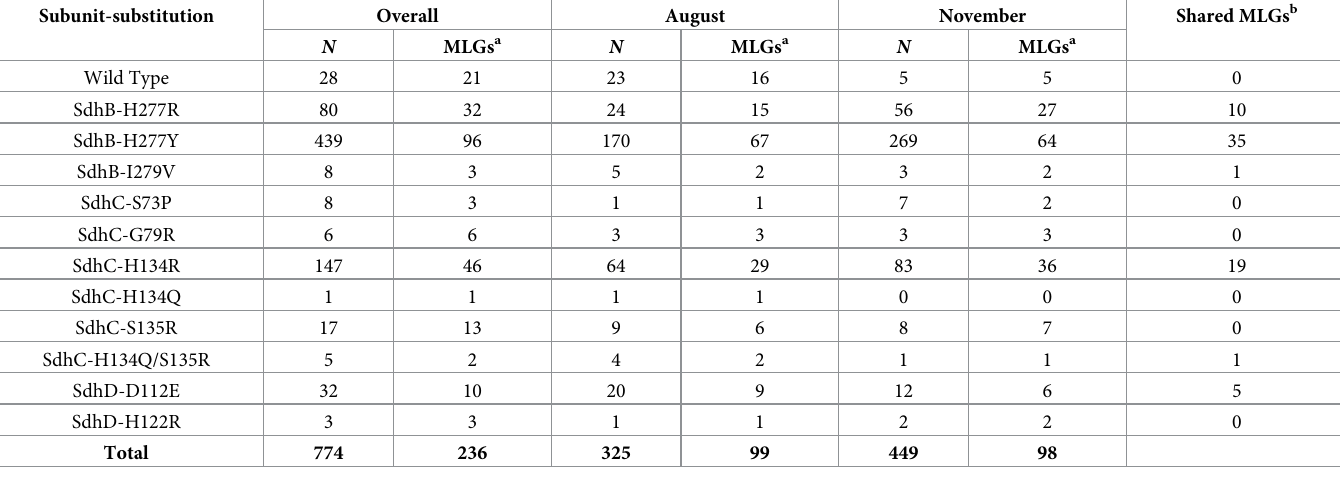
a Multi-locus genotype derived from combining microsatellite and mating-type data [28] b Number of multi-locus genotypes found in both sampling